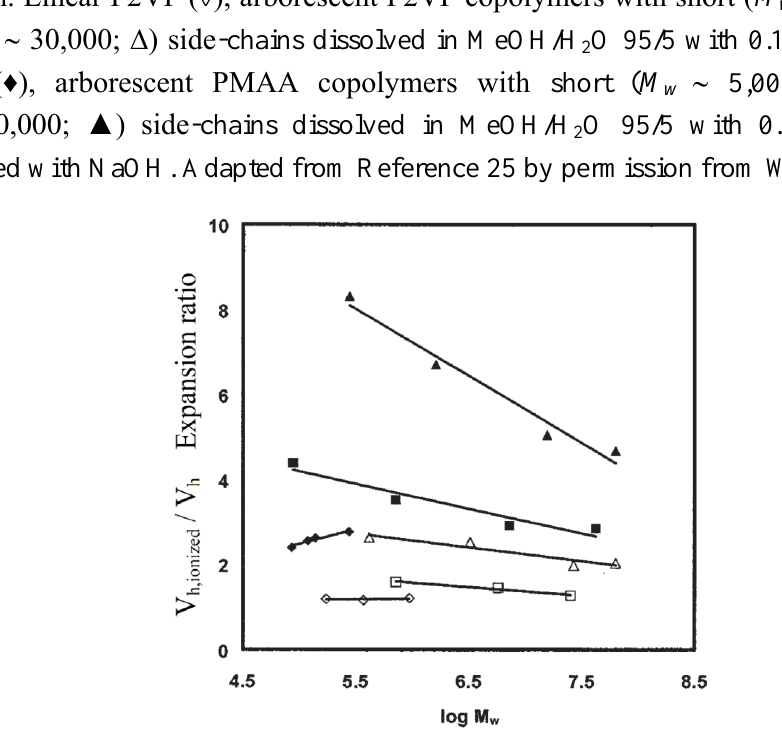
Figure 4. Hydrodynamic volume expansion for arborescent polystyrene- graft -poly(2- vinylpyridine), polystyrene- graft -poly(methacrylic acid), and their linear homologues upon ionization. Linear P2VP (◊), arborescent P2VP copolymers with short ( M long ( M  30,000; ∆) side-chains dissolved in MeOH/H w PMAA (♦), arborescent PMAA copolymers with short ( M